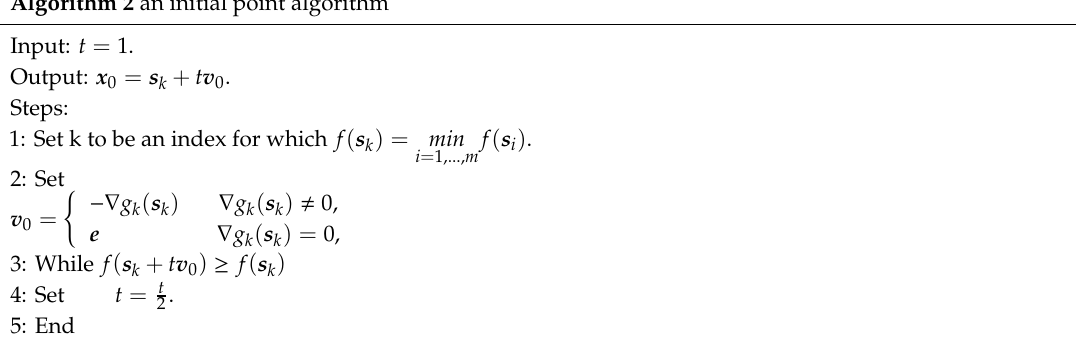
Algorithm 2 an initial point